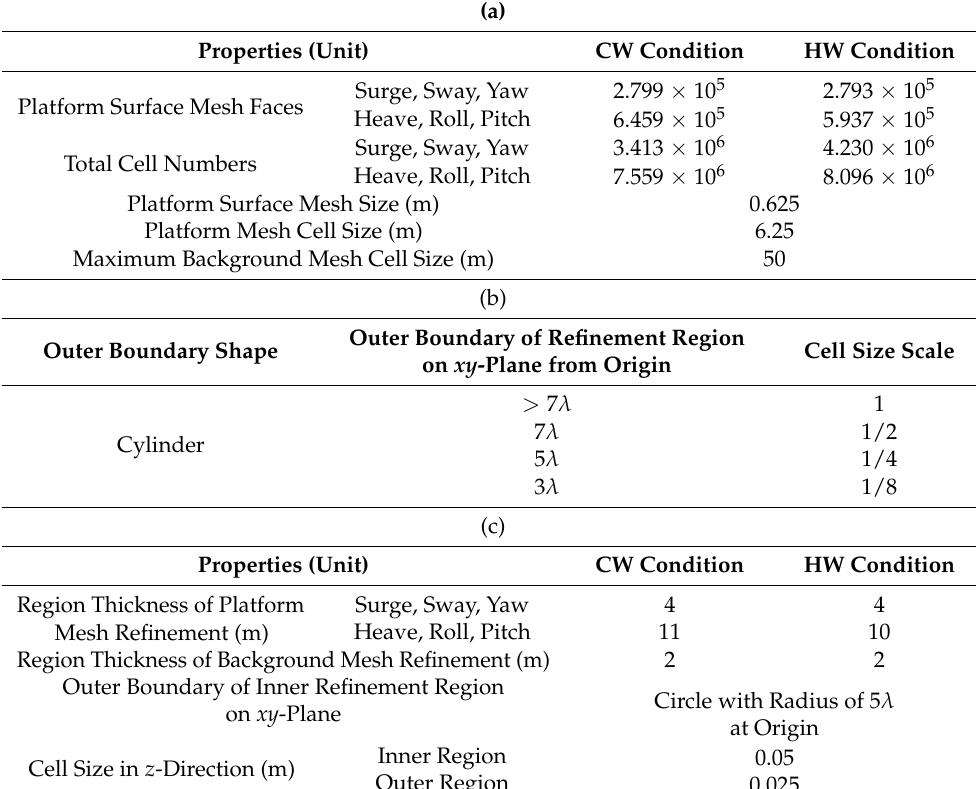
Table A2. Mesh parameters of viscous-flow modeling: (a) mesh number and cell size; (b) background mesh refinement setup; (c) mesh refinement setup at free